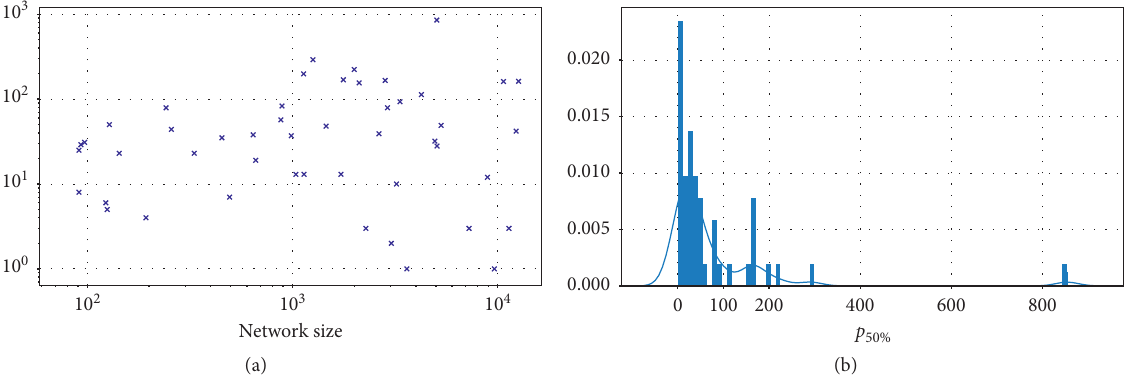
Figure 2: Distribution of p